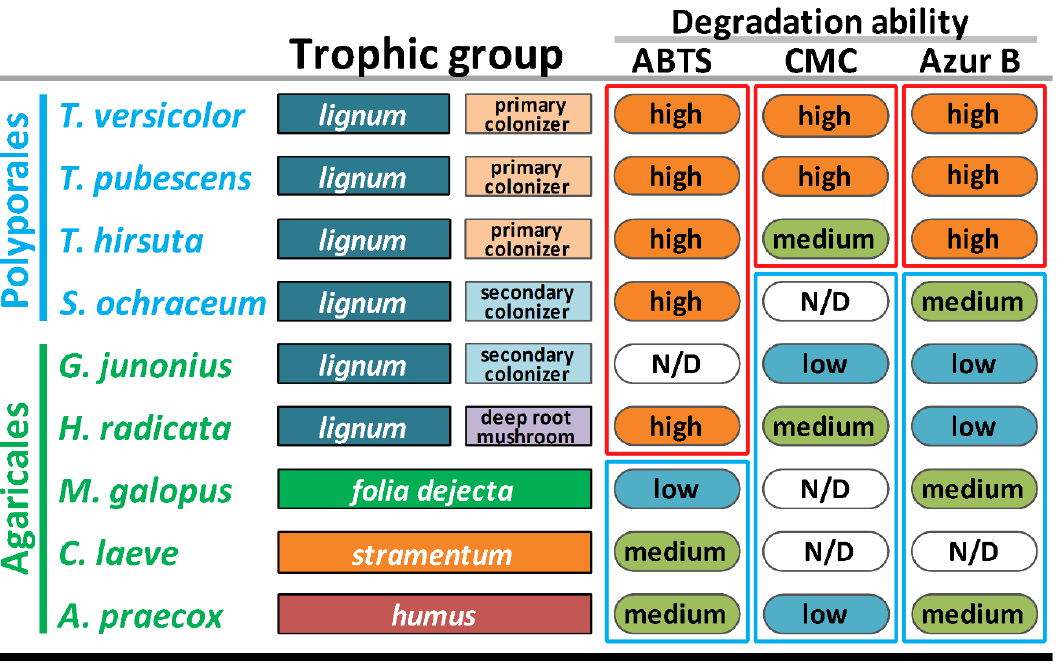
Figure 4. Ecological and biochemical characteristics of the selected fungi. Note: ABTS = 2,2’-azino-bis 3-ethylbenzothiazoline-6-sulfonic acid; CMC = carboxymethyl cellulose.